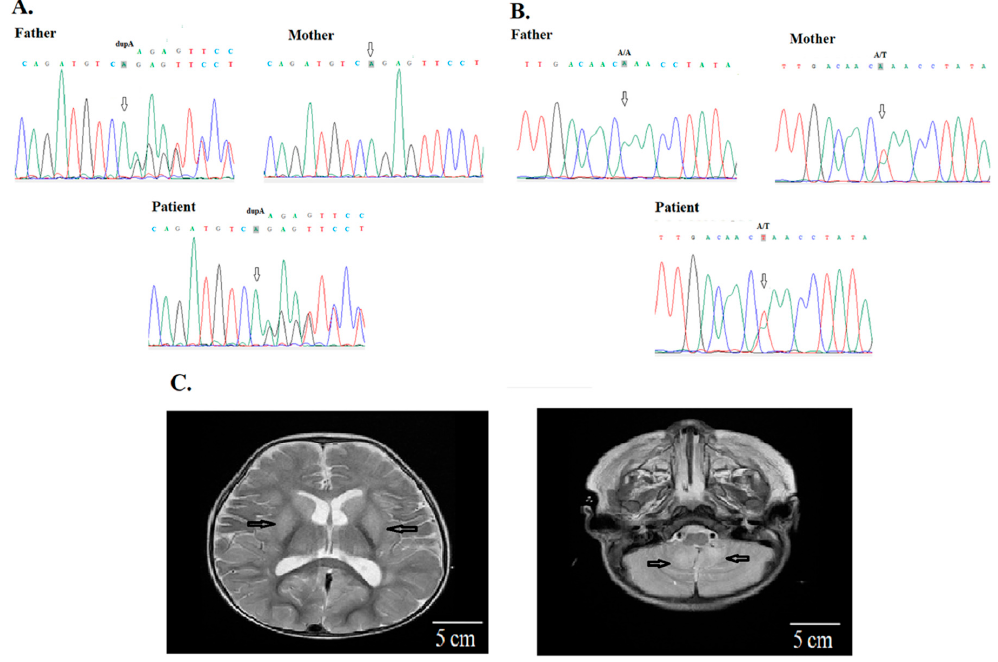
Figure 3. Patient 24 has compound heterozygous mutations of LAMA2, ( A ) c.1583dupA (p.Ser529GlufsTer19), and ( B ) c.6931A > T (p.Lys2311Ter) from the asymptomatic mother and father, respectively (arrows). ( C ) His MRI showed basal ganglion, thalamus, white matter and cerebellar vermis signal abnormalities. The finding indicated a dysmyelinating process. A creatine phosphokinase was 548 IU/L (reference values, 40-397 IU/L). The genetic study for spinal